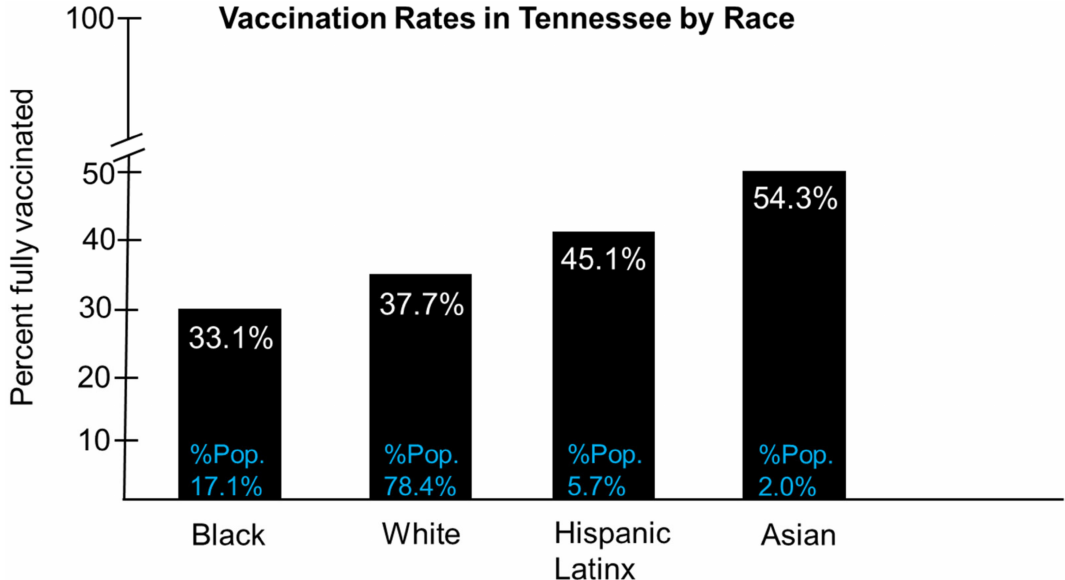
Figure 3. Vaccination rates in Tennessee by race. Vaccination rates in Blacks, Non-Hispanic whites, Hispanic/Latinx, and Asians appear as the percentage of the population they represent (Source https://www.tn.gov/health/cedep/ncov/data.ht ml (accessed on 11 July 2021).